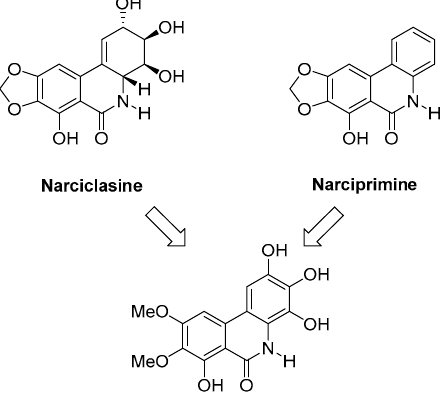
Figure 1. ( a ) Schematic summary of the involvement of BAs in cancer; ( b ) FXR expression decreases from healthy to cancer tissues.